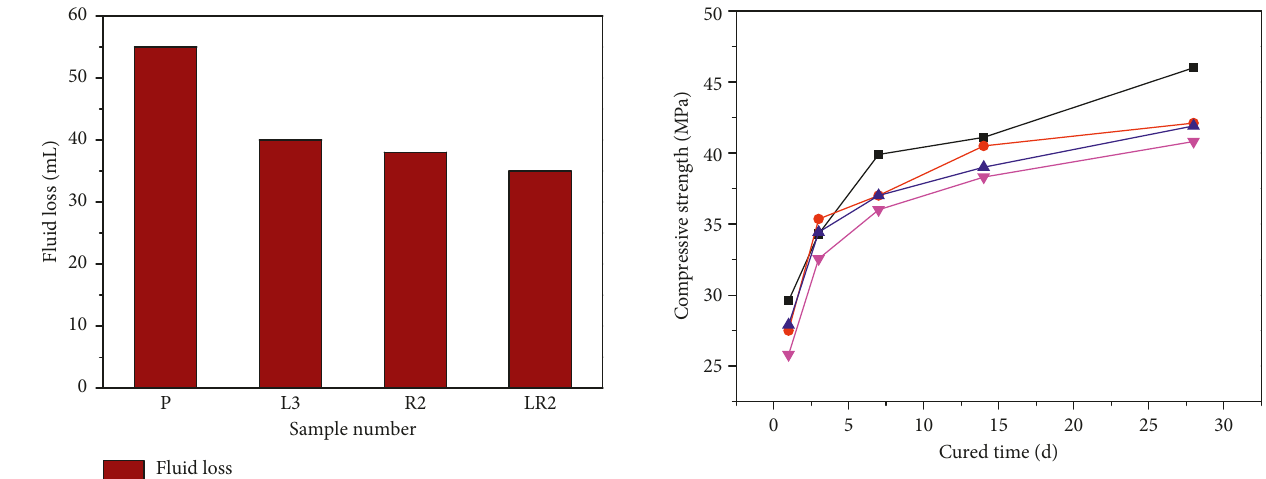
Figure 8: Dependence of rubber and latex on fluid loss of cement